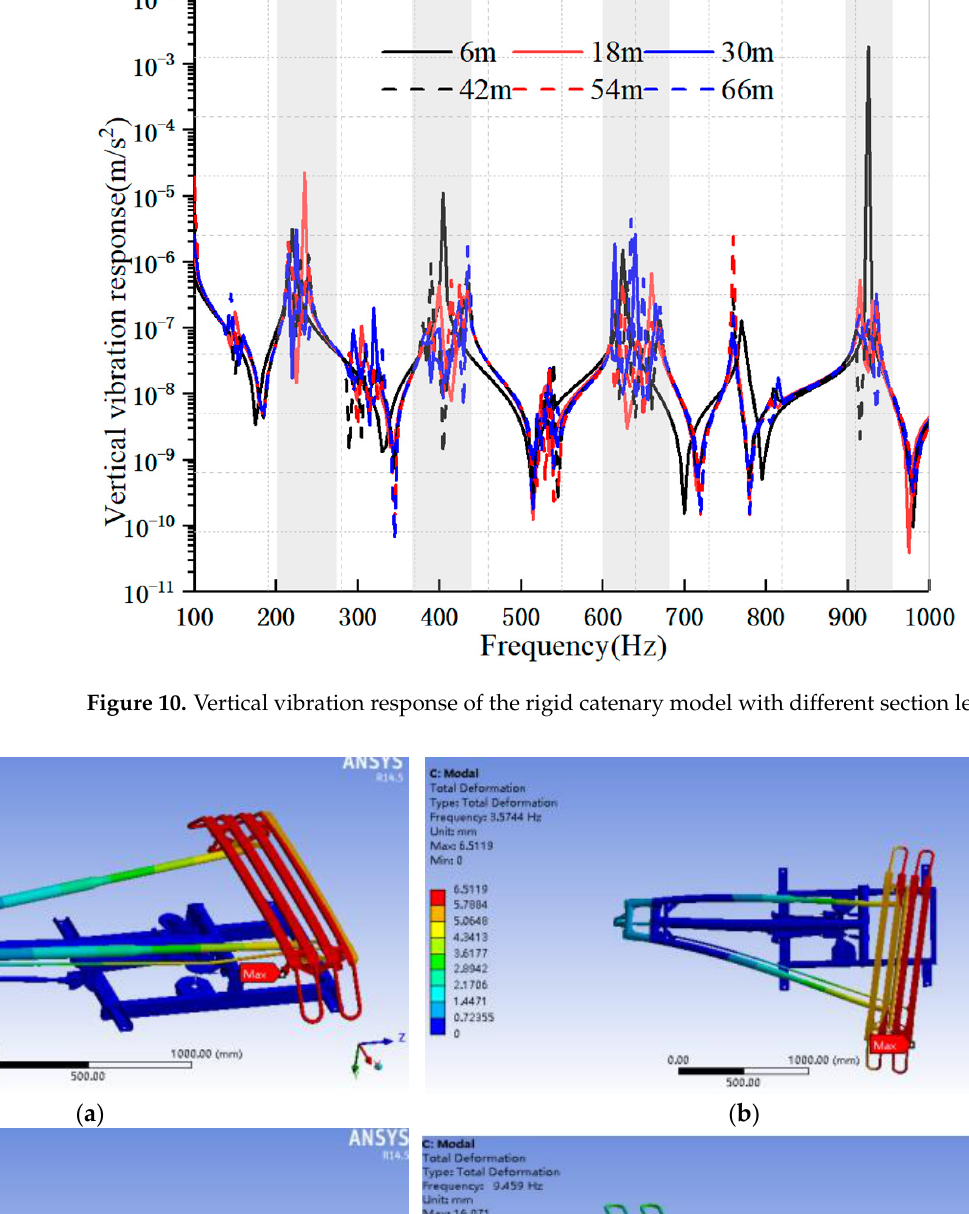
Figure 10. Vertical vibration response of the rigid catenary model with different section lengths.